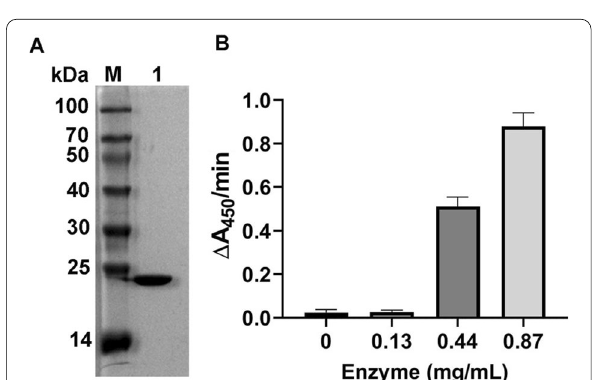
Fig. 3 Purification and enzyme activity of C25GH19B. A SDS-PAGE analysis of the purified C25GH19B. M, protein molecular weight marker; Lane 1, the purified protein of C25GH19B. B The bacteriolytic activity of C25GH19B at different enzyme concentrations determined by using lyophilized M. luteus as